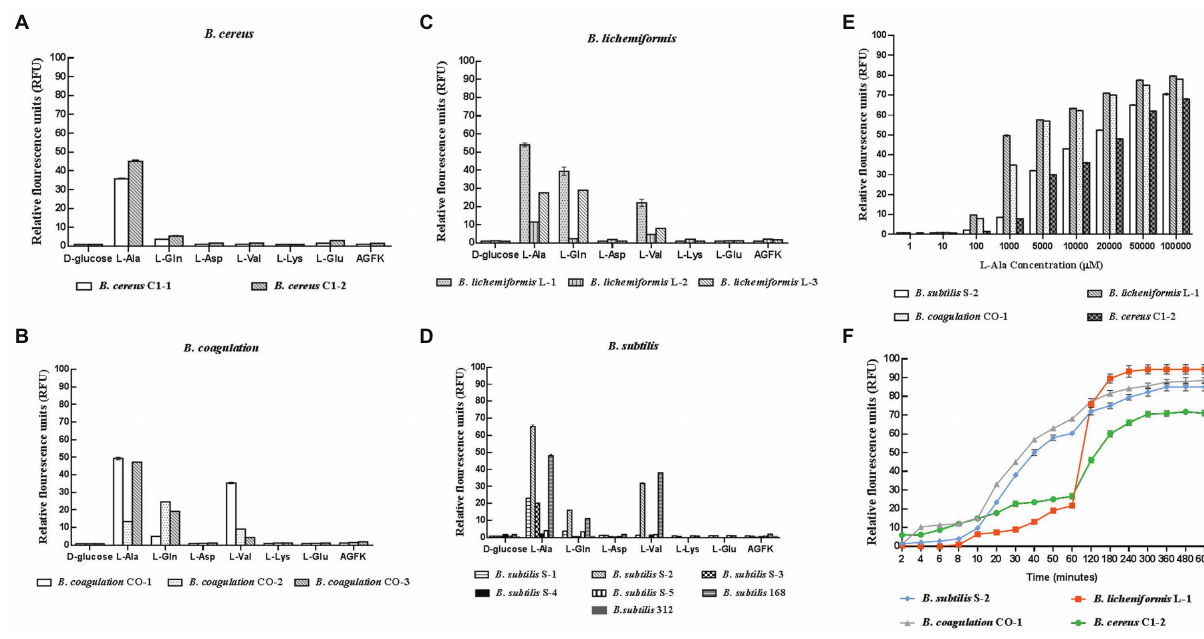
FIGURE 1 | Response of different probiotic Bacillus strains to different nutrient germinants. D-glucose, L-alanine (L-Ala), L-glutamine (L-Gln), L-aspartate (L-Asp), L-valine (L-Val), L-lysine (L-Lys), L-glutamate (L-Glu), and complex sprouting agents AGFK. (A–D) Bacillus cereus , Bacillus coagulans , Bacillus lichemiformis , Bacillus subtilis , respectively. (E) Concentration effect of L-alanine on DPA release of spores. (F) Time effect of L-alanine treatment on DPA release of